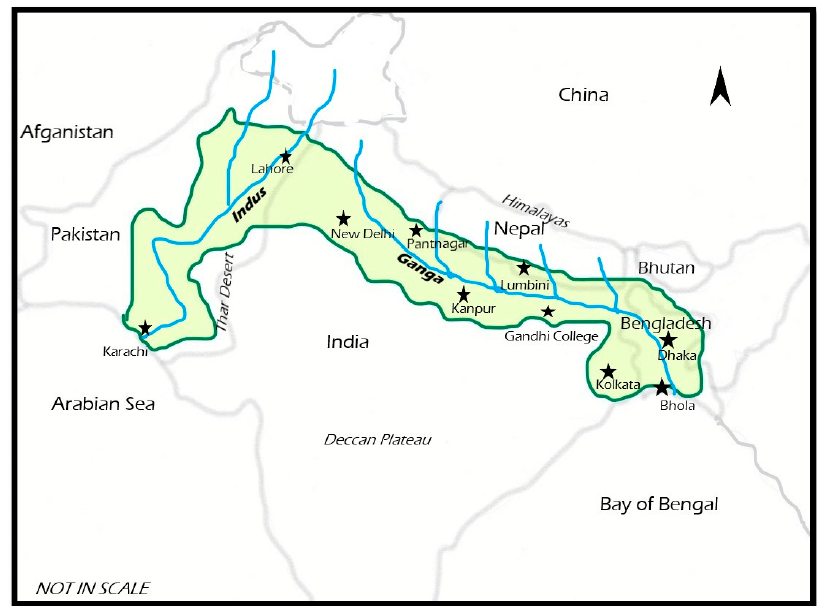
Figure 1. Study area—Indo Gangetic Plain (IGP) and the location of AErosol RObotic NETwork (AERONET) stations (starred).